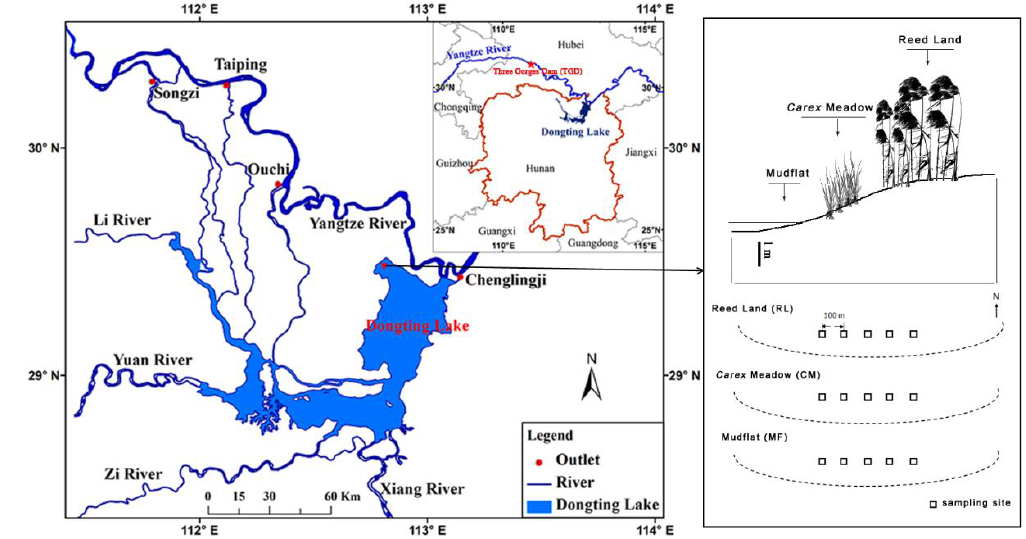
Figure 1. Maps of Dongting Lake showing the location and elevation of the sampling area.